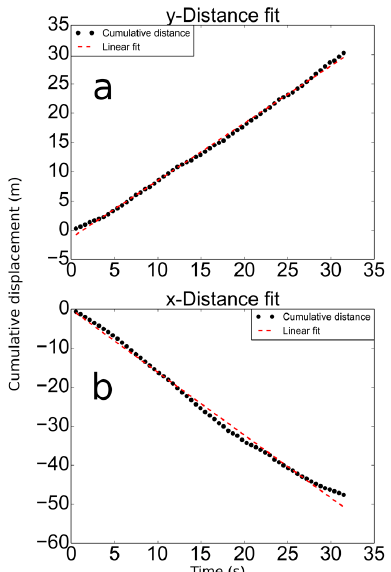
Figure 7. Linear fits of the cumulative displacements (Equation (7)) from optical flow analysis. ( a ) Vertical component; ( b ) Horizontal component.